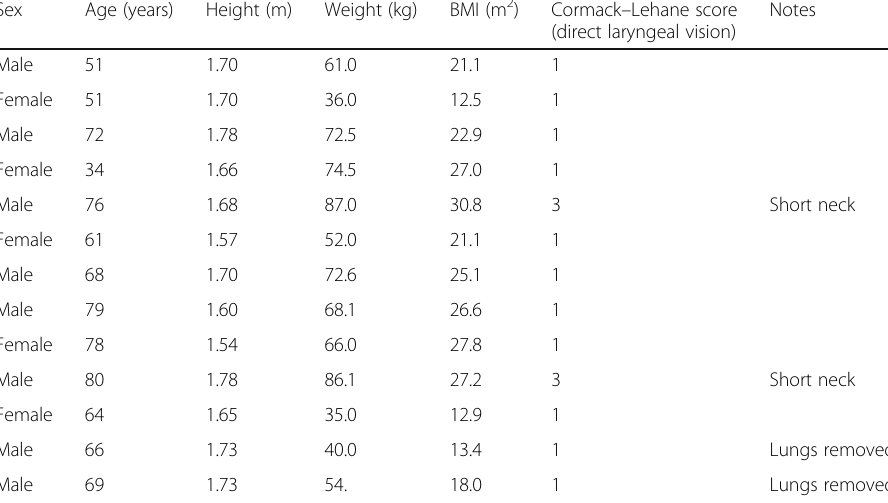
Table 1 Characteristics of cadavers used to test tracheal needle puncture techniques